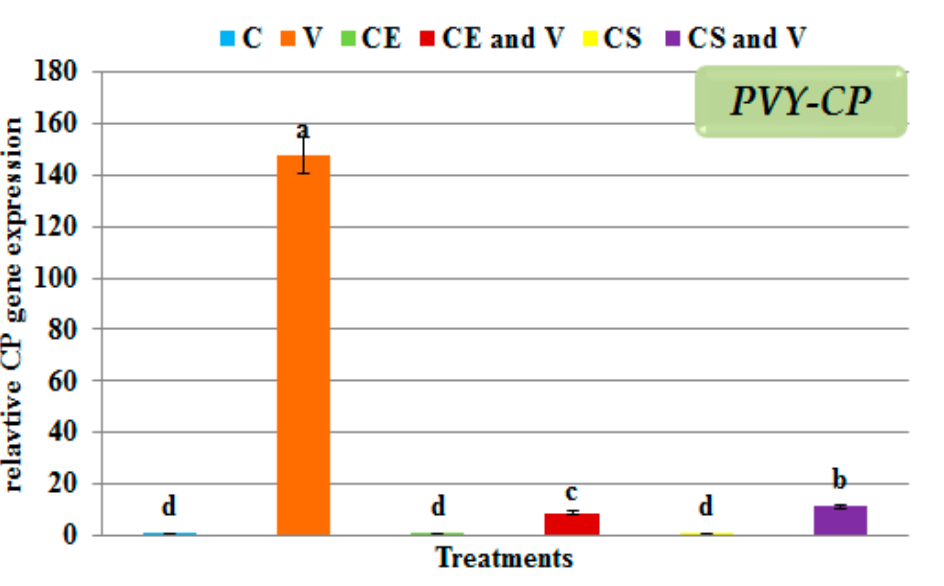
Figure 8. The quantitative gene expression levels of PVY-CP in PVY-infected potato leaves at 28 days post-inoculation. C: control potato plants; V: potato plants inoculated with PVY; CE: potato plants treated with Egyptian nanoclay; CE and V: potato plants inoculated with Egyptian nanoclay 48 h before PVY inoculation; CS: potato plants treated with standard nanoclay; CS and V: potato plants inoculated with standard nanoclay 48 h before PVY inoculation. The columns reflect the average value of five biological replicates, while the bars represent the standard deviation (SD). According to Tukey’s HSD test ( p ≤ 0.05), the values of each column following the same letter (a/b/c/d/e/f) do not significantly differ.